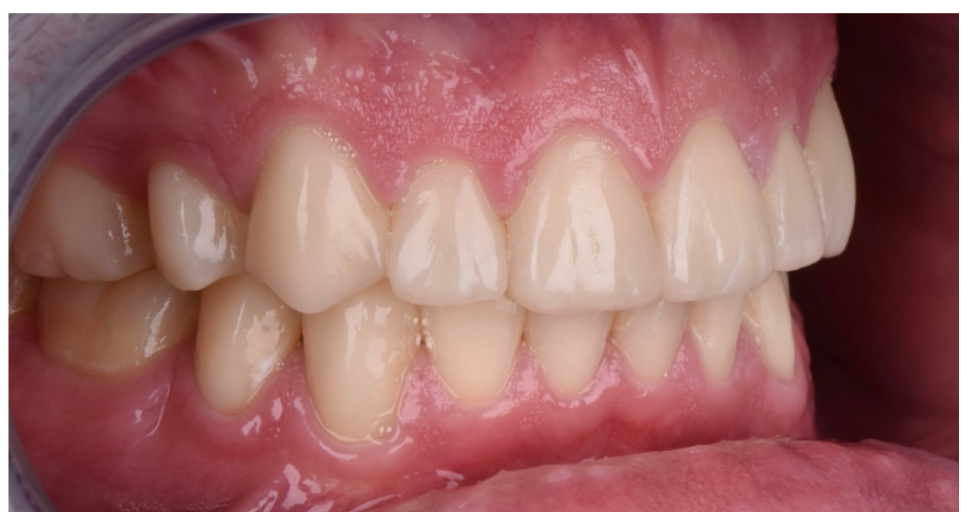
Figure 33. Final intraoral picture (right).